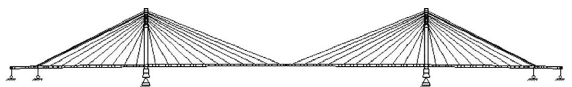
Figure 12: Plane frame finite-element model of Yonghe